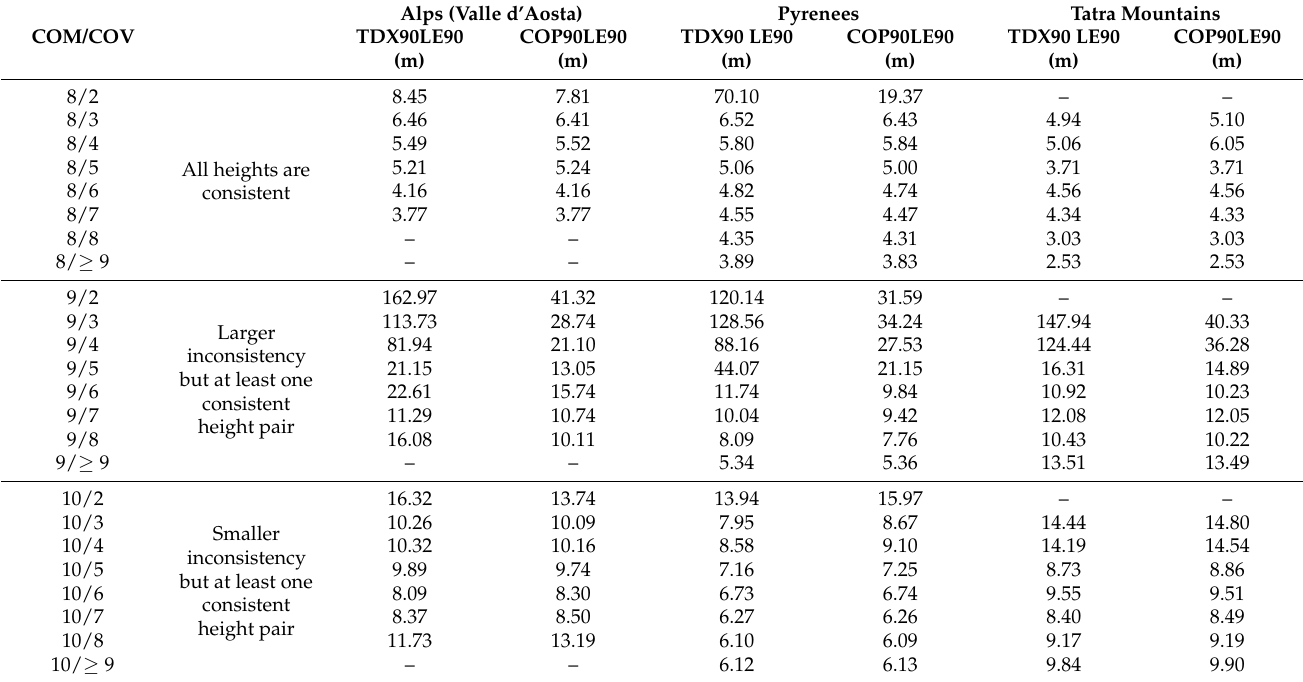
but at least one consistent height